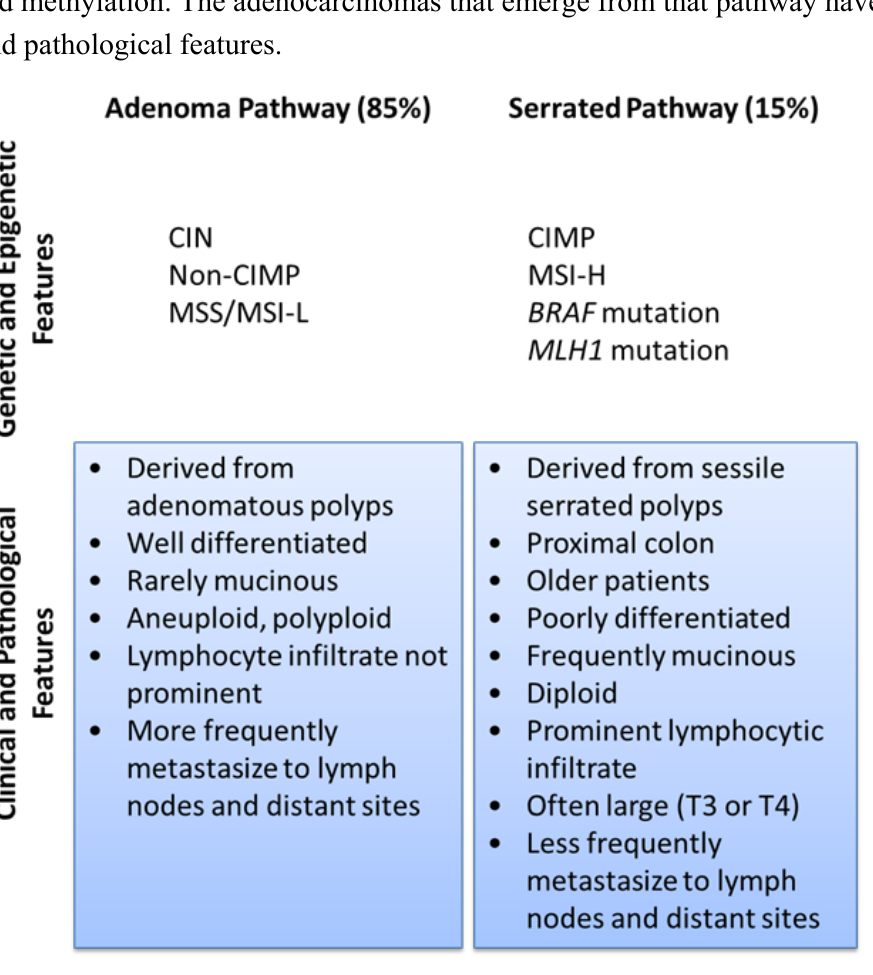
Figure 2. Relationship of CIMP expression phenotype and microsatellite instability. There is significant overlap between MSI-H tumors and CIMP-H tumors, although microsatellite stable (MSS) tumors and tumors with a low level of MSI (MSI-L) may have high levels of CpG island